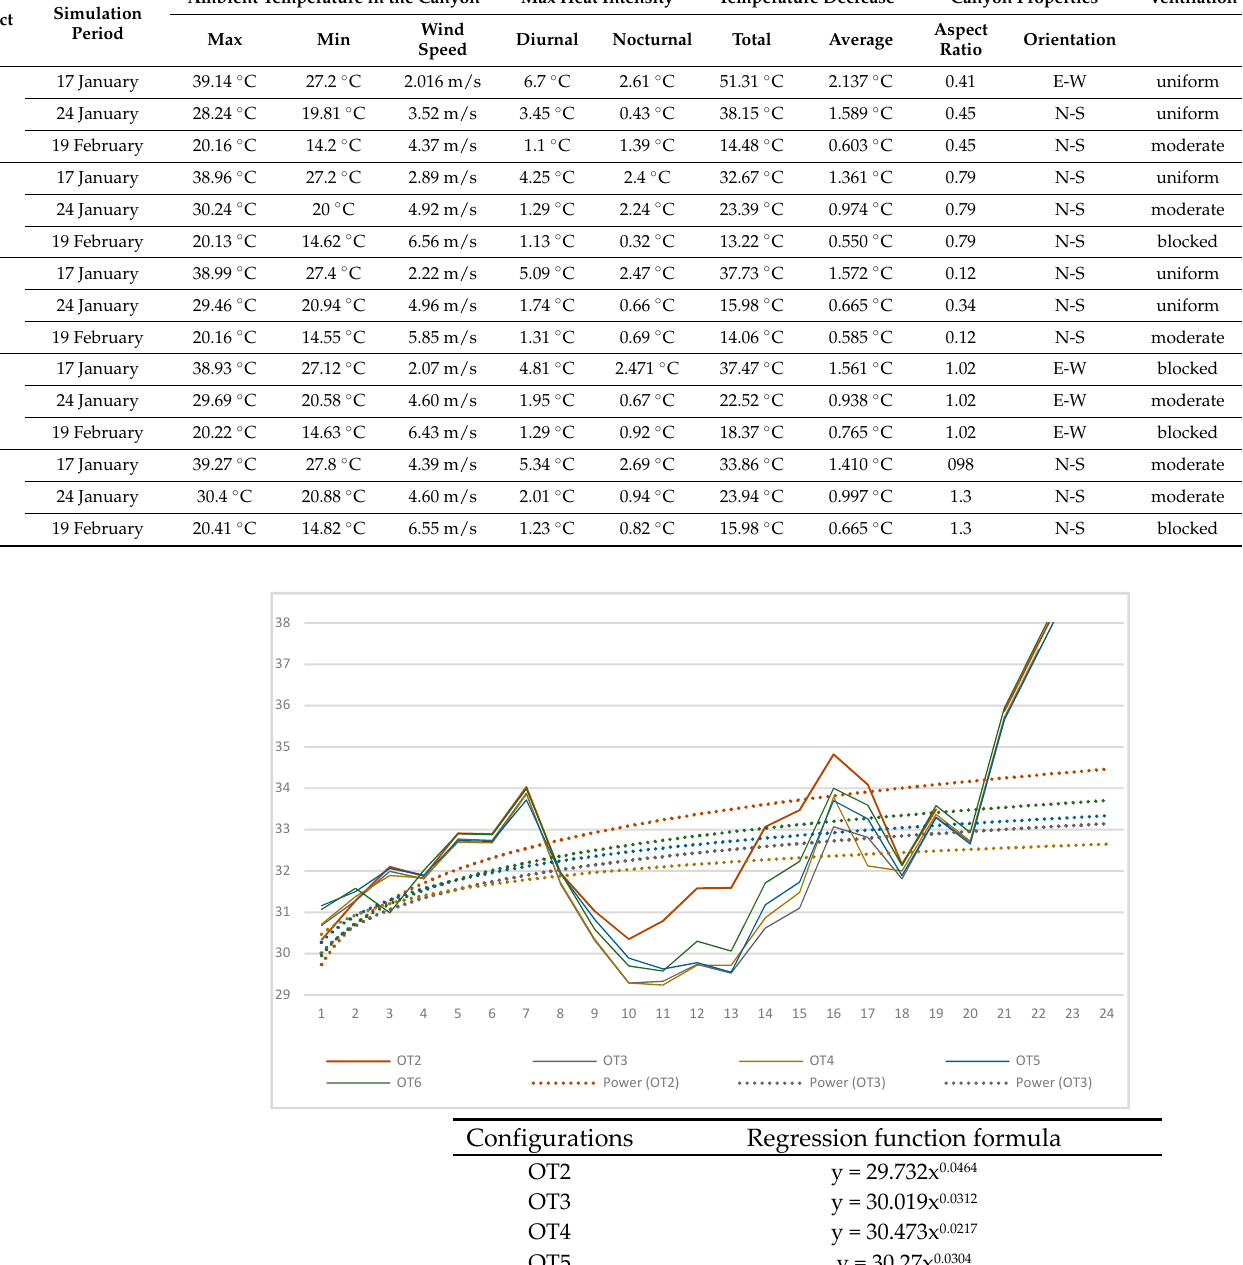
Table 11. Summary of main climatological variables during the simulation period in open - type ar- rangements.